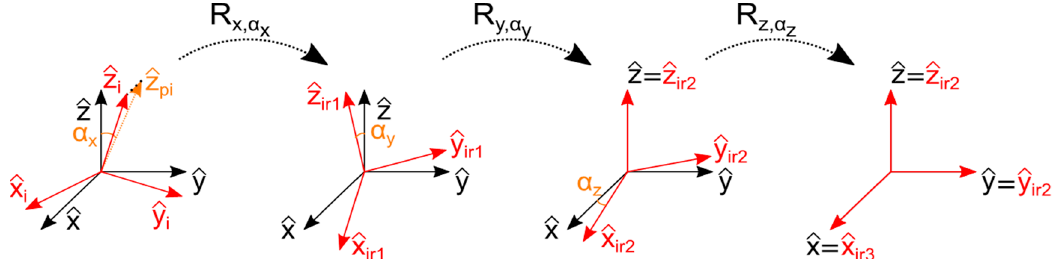
Figure A3. Coordinate system transformation to get the ICS vectors ( ˆ x i , ˆ y i , ˆ z i ), and hence the LCS of each radar, equally oriented as the GCS ones ( ˆ x , ˆ y , ˆ z ).